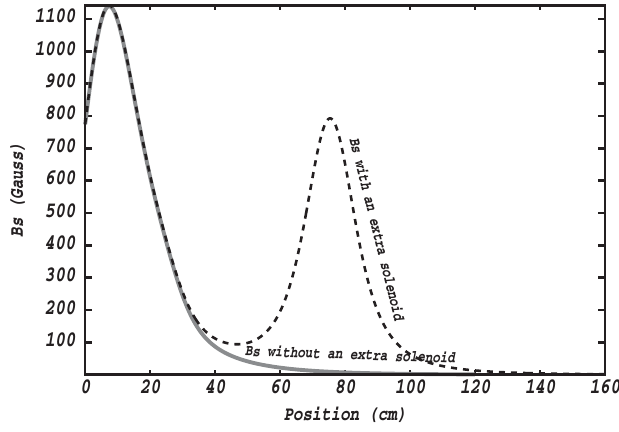
FIG. 4. B profile for nonlinear s